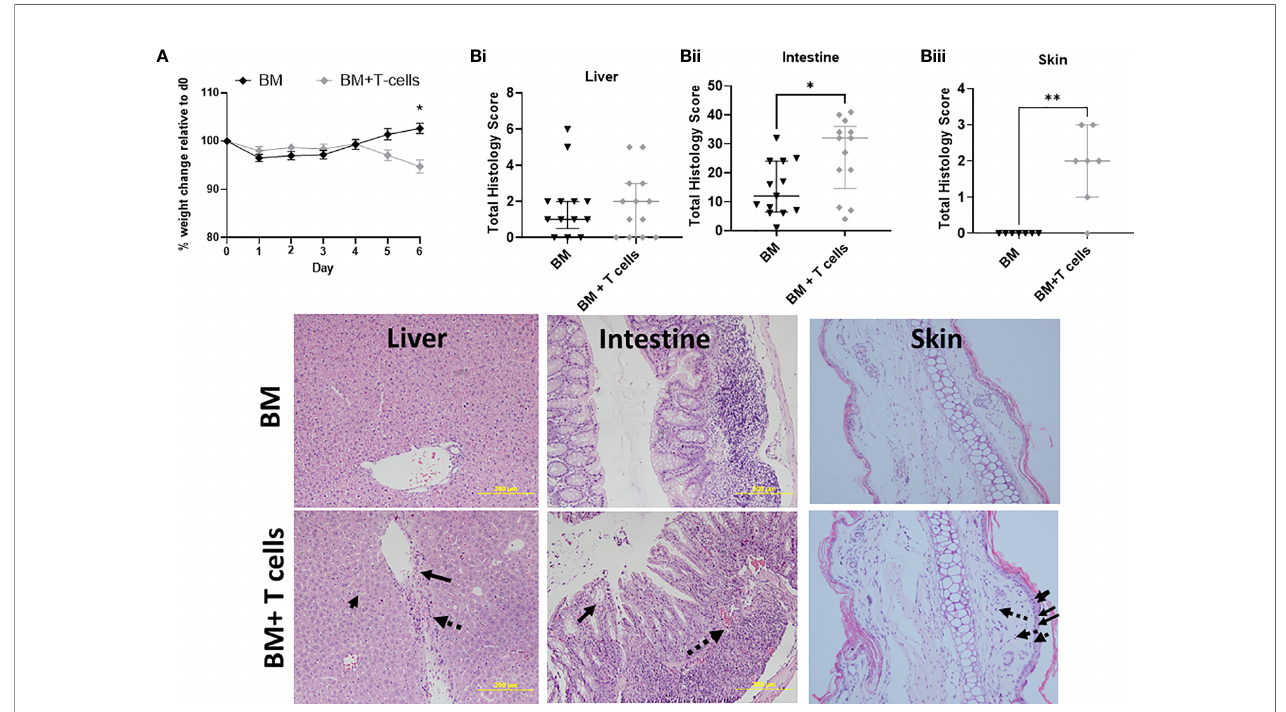
FIGURE 1 | Onset of GvHD at day 6 post-transplantation after myeloablative chemotherapy- Signi fi cant differences in weight and high histological scores indicate the onset of GvHD at day 6 in mice transplanted with BM+T-cells compared to mice transplanted with BM only. (A) Post-transplant, signi fi cant difference in weight are observed at day 6 between mice transplanted with BM and BM+T-cells (*p<0.05). Two-Way RM ANOVA with Sidak ’ s multiple comparison test. Data is Mean ± SEM. n=13. (B) Mice transplanted with BM+T-cells showed (i) no change in GVHD Histology score compared with animals transplanted with BM only in the liver and (image) although representative sections show apoptotic bodies (small solid arrow), endothelialitis (large solid arrow) and lymphocytic in fi ltrate (dotted arrow). However (ii) increased GvHD score was seen in the intestine samples from the BM+ T cells cohort as evidenced by (image) representative histology images showing crypt destruction (solid arrow) and in fl ammatory in fi ltrate (dotted arrow). (iii) Cutaneous GvHD is also evident in this model with abundant apoptotic/necrotic keratinocytes (solid arrows) and intradermal lymphocyte in fi ltration (dotted arrows) *p < 0.05. Unpaired Mann-Whitney U-test. Data is median with interquartile range and n=3-6 naïve; n=12-13 BM and BM+T cells (liver and intestine) and n=7 (skin). **p <